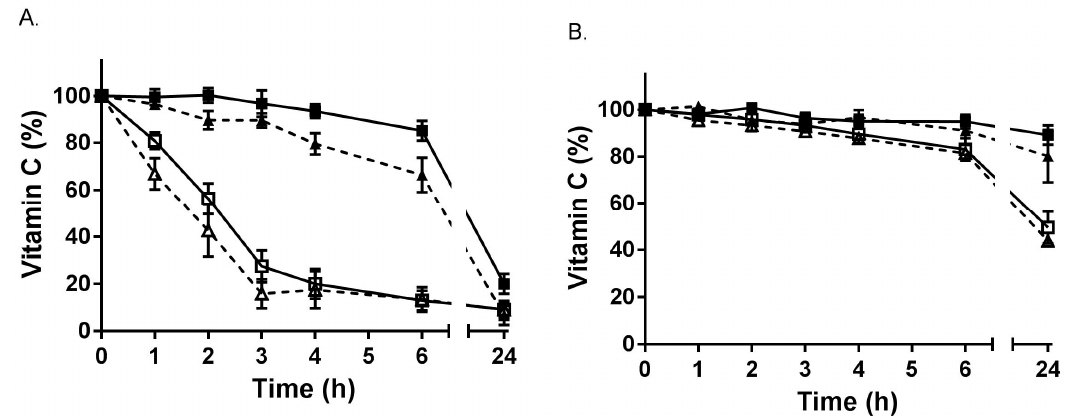
Figure 3. Stability of vitamin C in plasma. ( A ) EDTA-plasma was incubated on ice ( (cid:4) , (cid:78) ) or at room temperature ( (cid:3) , (cid:52) ). ( B ) Heparin-plasma was incubated on ice ( (cid:4) , (cid:78) ) or at room temperature ( (cid:3) , (cid:52) ). Samples without TCEP are shown with dashed lines, and those with TCEP using solid lines. Samples were extracted for ascorbate HPLC analysis at indicated time points. Data represent the mean ± SEM ( n = 3–7). Repeated measure one-way ANOVA with Dunnett’s test for multiple comparison showed a significant decrease in ascorbate in EDTA-plasma on ice from 4 h (in the absence of TCEP, p = 0.016), and at room temperature from 1 h ( p = 0.026). There was no significant decrease in ascorbate in heparin-plasma on ice for 24 h ( p = 0.544), or at room temperature over 6 h ( p = 0.396).